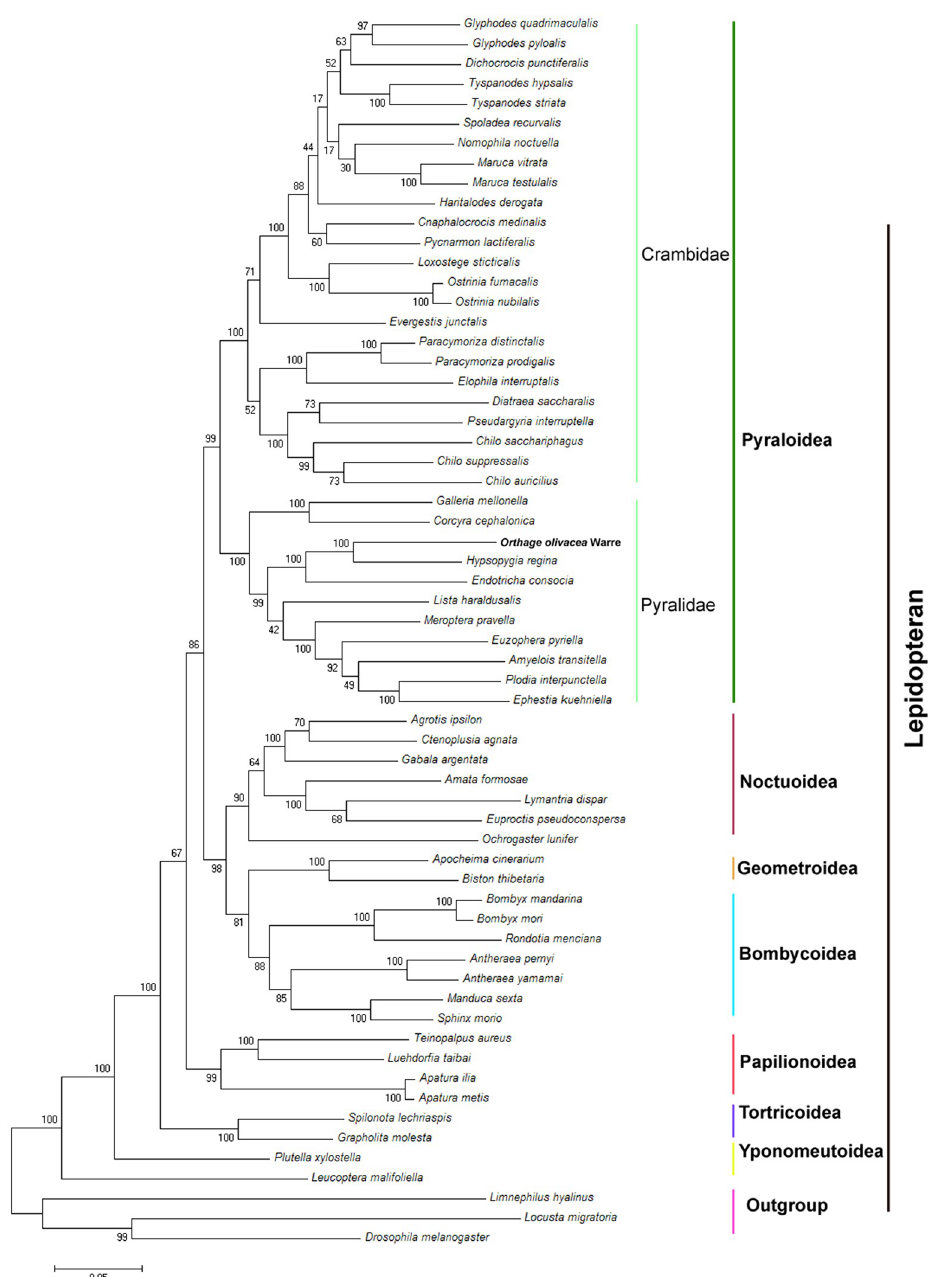
Fig 7. Phylogenetic relationships tree among Lepidopteran insects. The Maximum Likelihood method was used in the tree constructing. Bootstrap values (1000 repetitions) of the branches are indicated. Limnephilus hyalinus (NC_044710.1), Drosophila incompta (NC_025936) and Locusta migratoria (JN858212) were used as